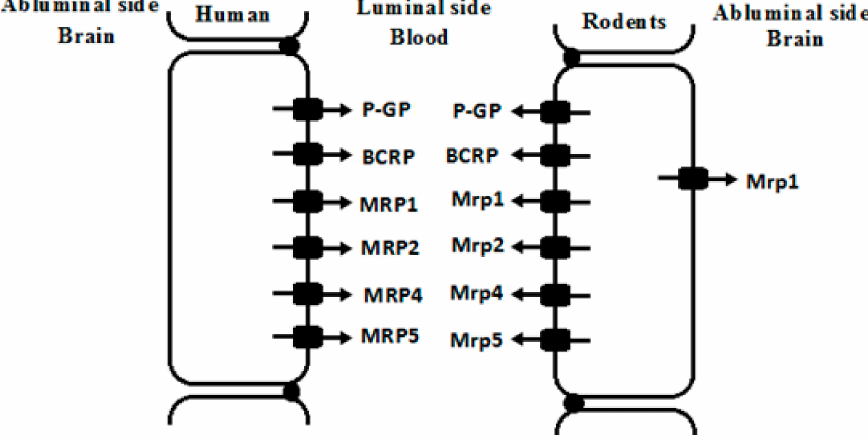
Figure 2. Possible location of some ATP-binding cassette (ABC) drug transporters in brain microvessel endothelial cells of human and rodents. P-GP, glycoprotein; BCRP, breast cancer resistance protein; MRPs/Mrps, multidrug associated resistance